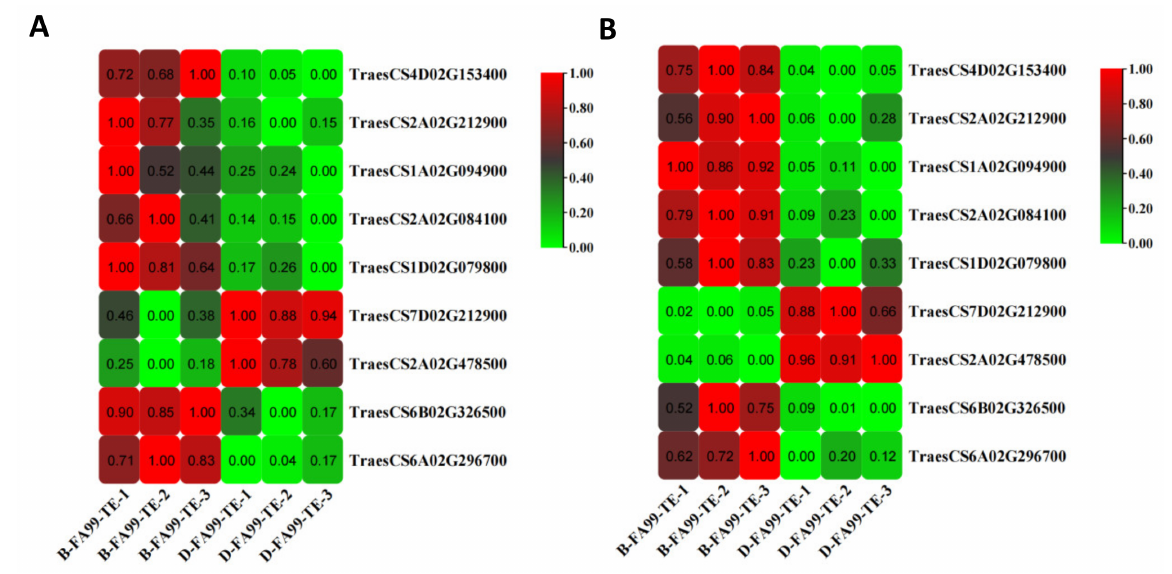
Figure 7. Heatmap showing the relative expression level of the nine key genes determined by RNA-seq analysis ( A ) and qRT-PCR ( B